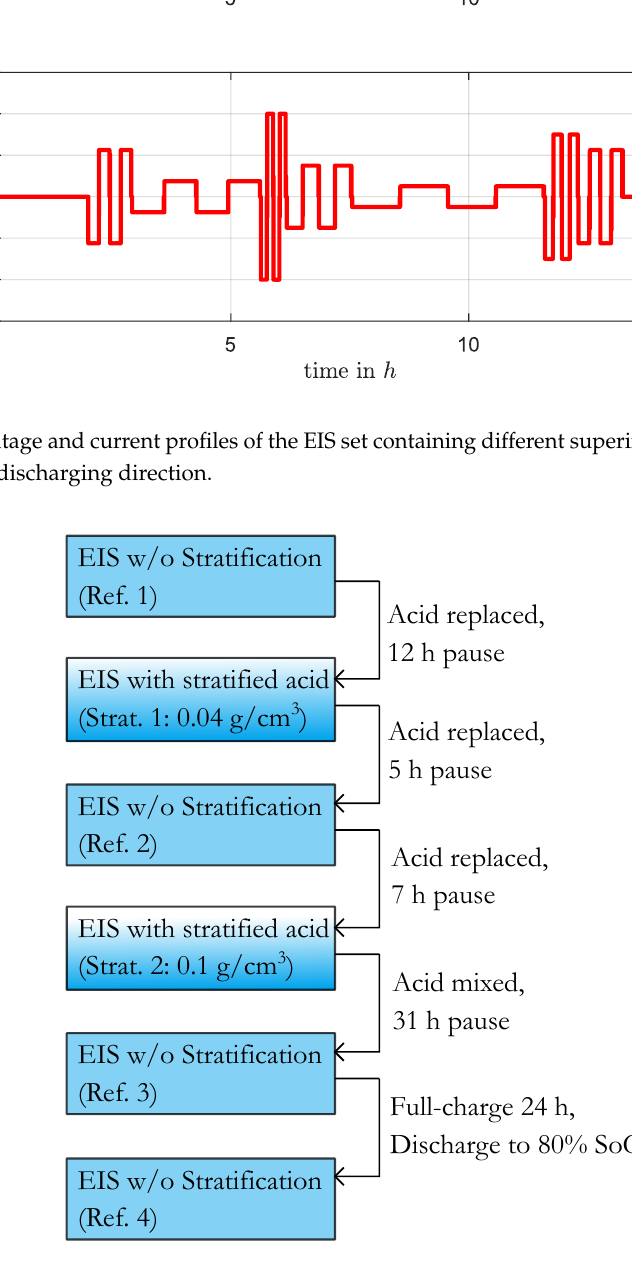
Figure 2. The sequence of EIS sets performed with homogeneous and stratified acid. The density values specify the measured acid concenctration difference between top and